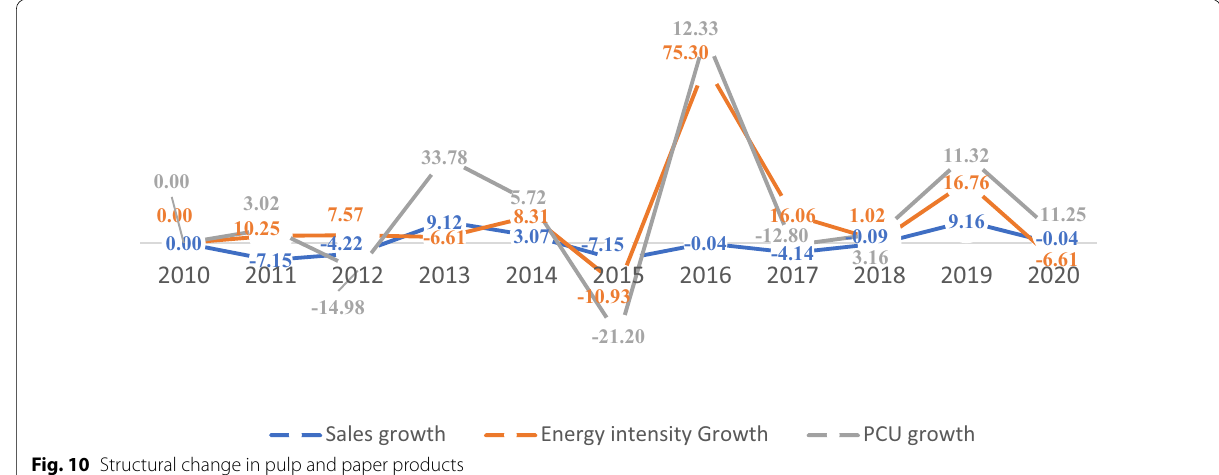
Fig. 10 Structural change in pulp and paper products